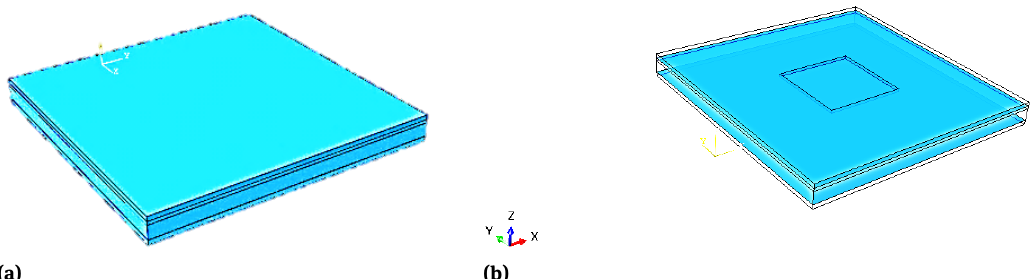
Figure 1: FEM models of ship sandwich plate: (a) the intact sandwich plate, (b) the damaged sandwich plate where damage occurs inside the core